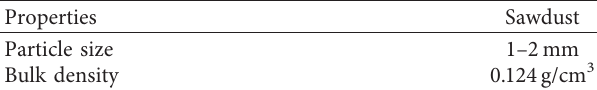
Table 1: Properties of wood sawdust.